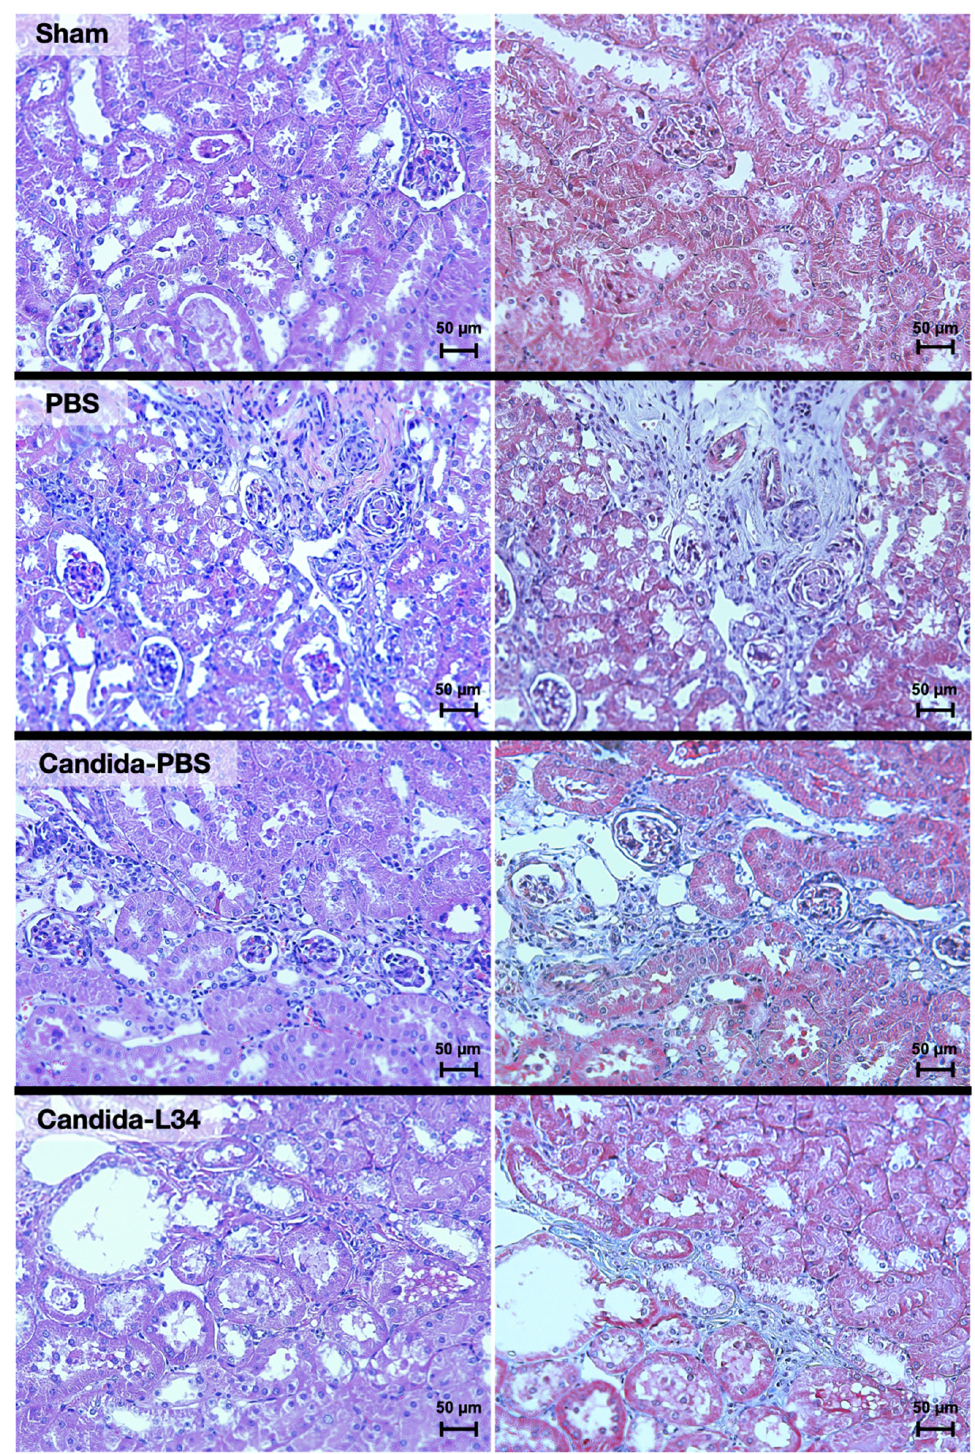
Figure 2. The representative kidney histopathological pictures stained by Hematoxylin and Eosin (H&E) ( left ) or Masson’s Trichrome color ( right ) (original magnification 200 × ) of Sham control, 5/6 nephrectomy mice with phosphate buffer solution (5/6Nx + PBS), Candida -administered 5/6 nephrectomy mice with Lacticaseibacillus rhamnosus L34 (5/6 Nx + Candida + L34) or without the probiotics (5/6 Nx+ Candida ) are demonstrated.